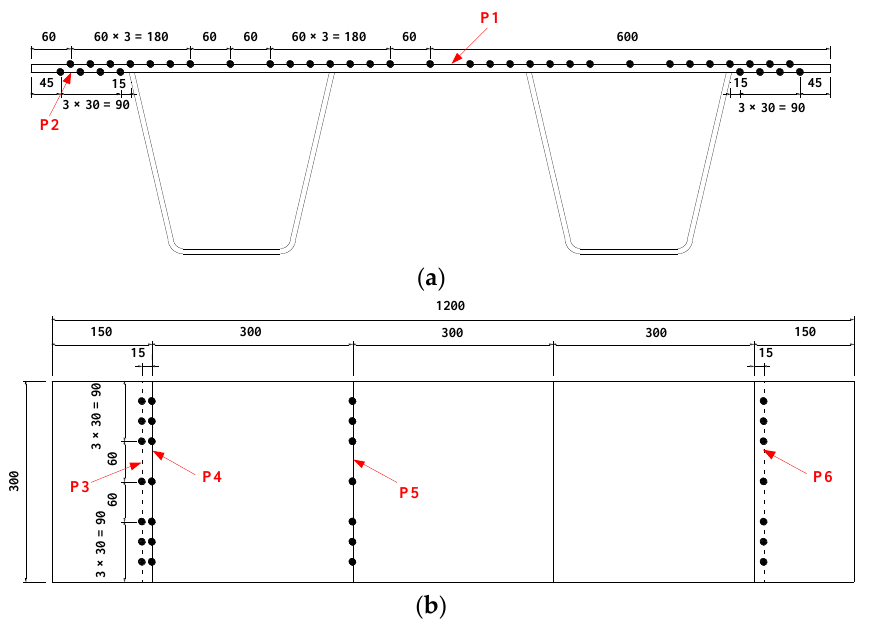
Figure 4. Diagram of the measurement points of layout paths: ( a ) cross section diagram; ( b ) plan diagram (units: mm).